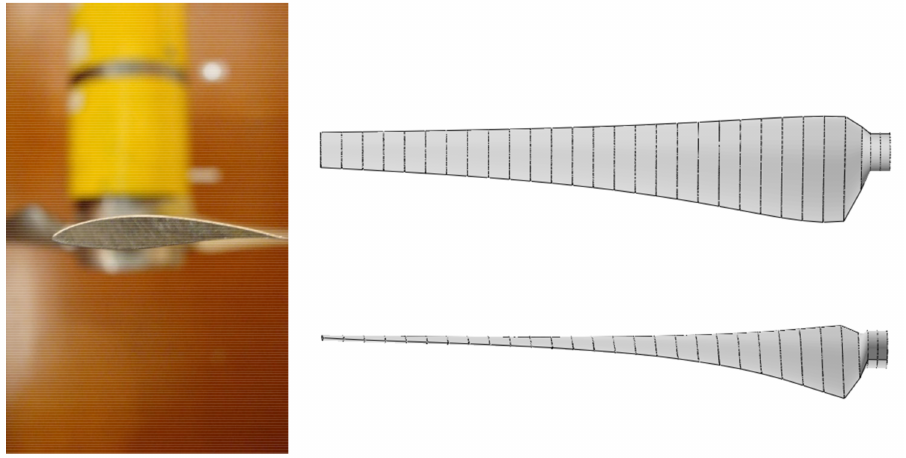
Figure 4. NREL S826 airfoil profile ( left ); blade used in T1 and T2 turbines ( right ).